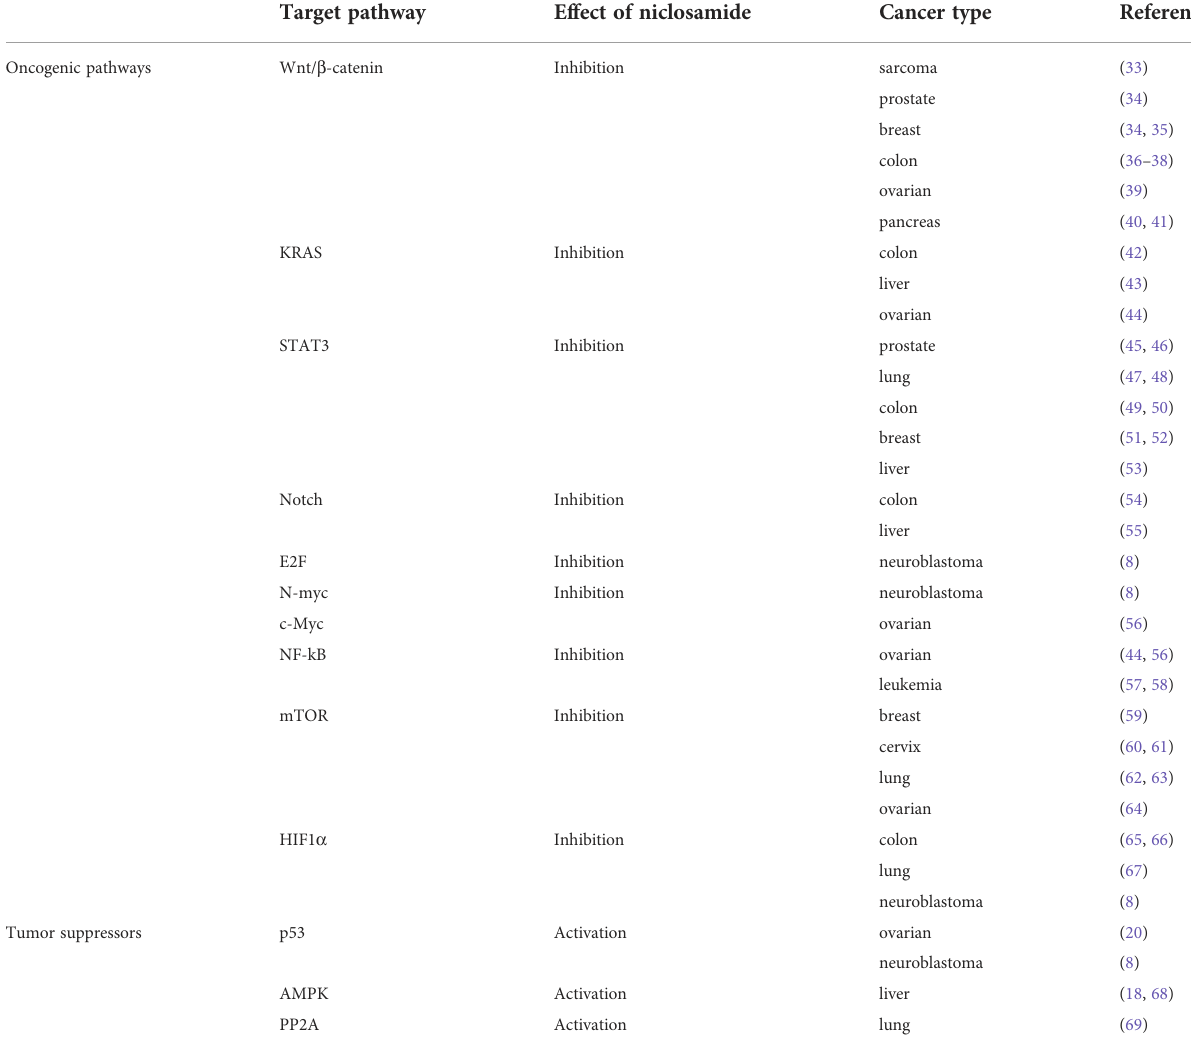
TABLE 1 Niclosamide activates tumor suppressor and inhibit oncogenic